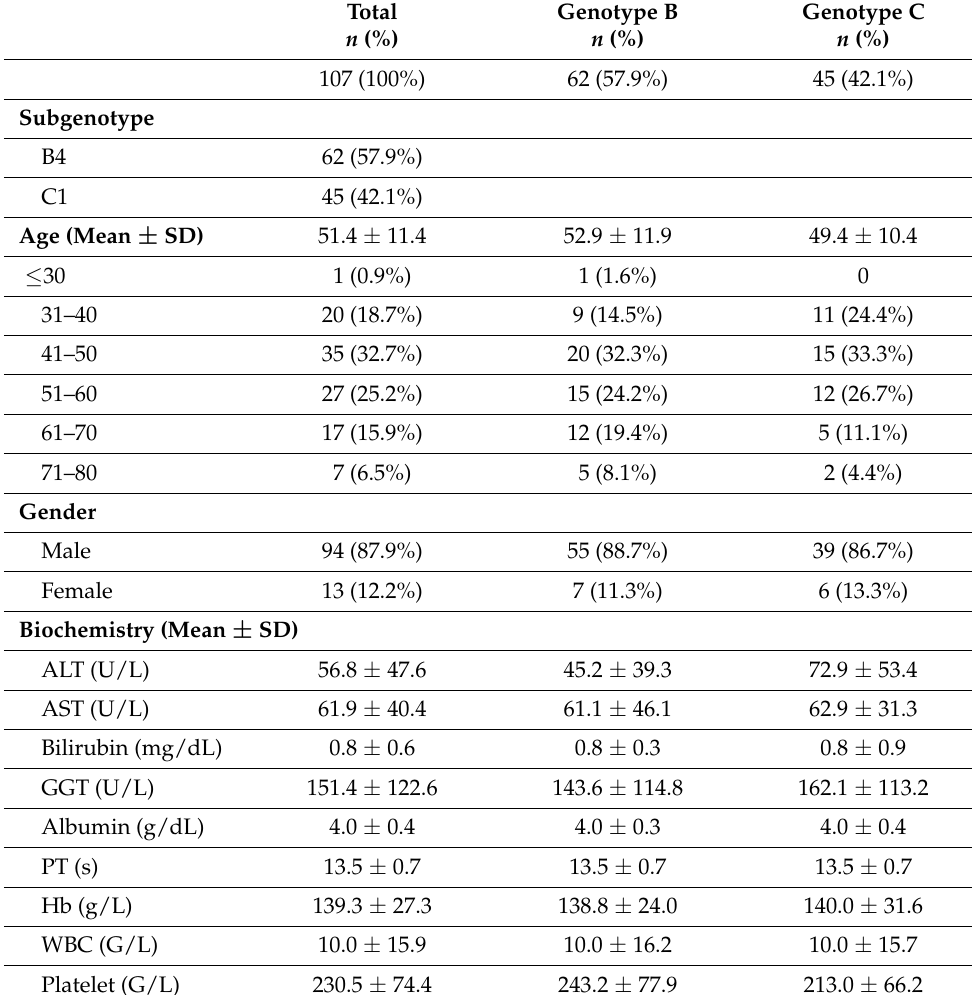
Table 2. Distribution of patient characteristics with HBV